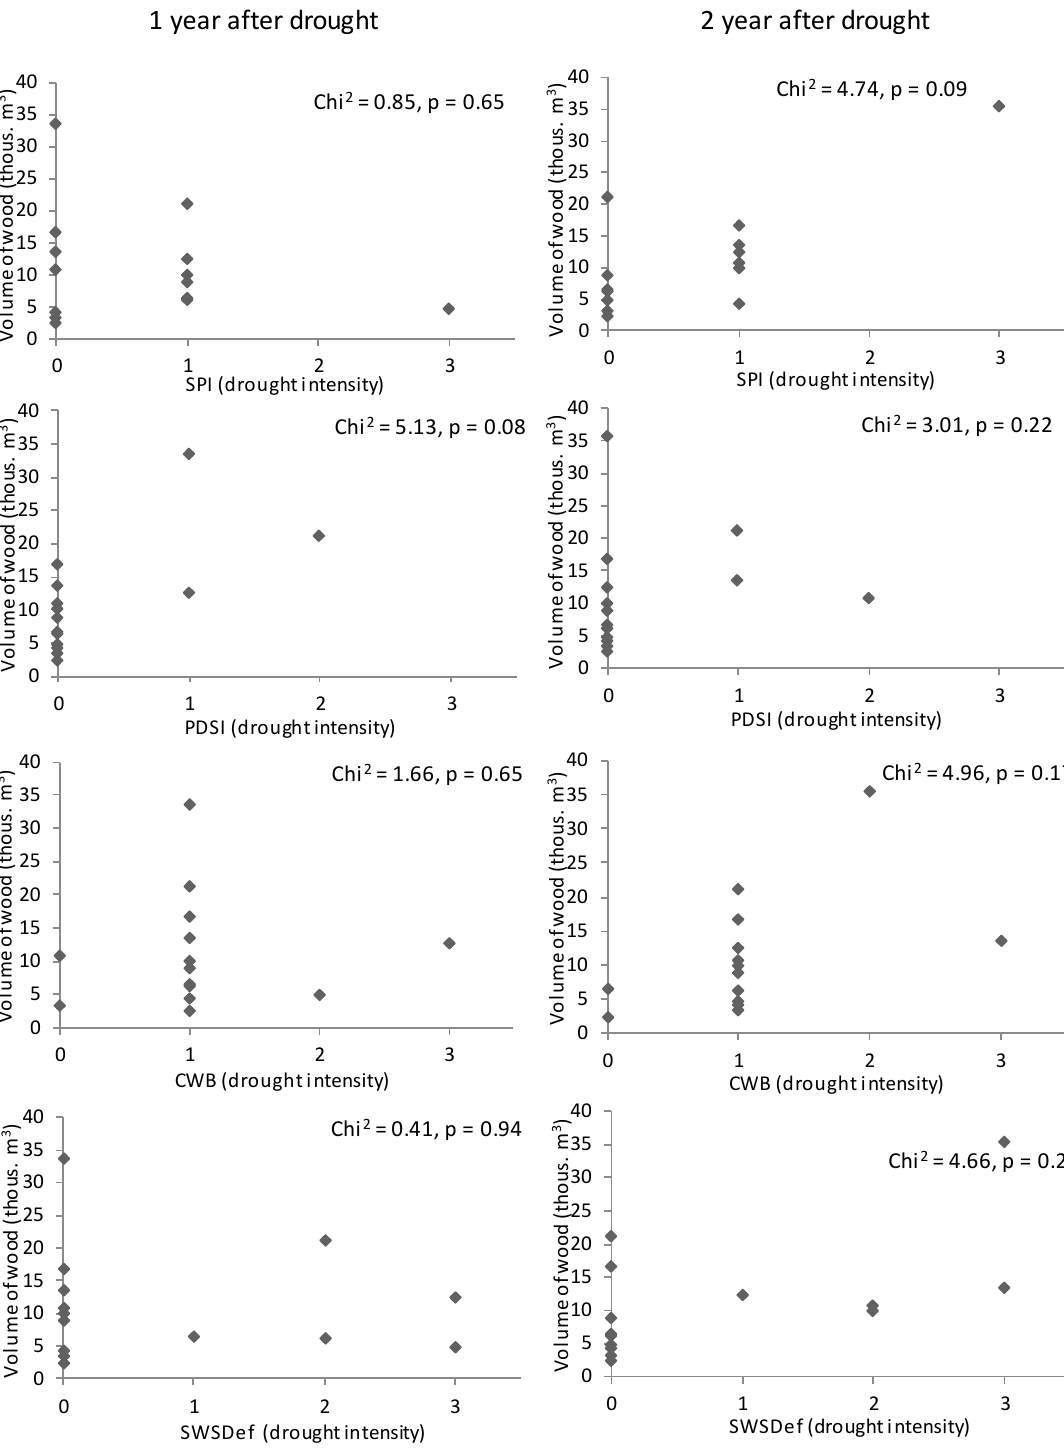
Figure 5. Relationship between drought indices (0—no drought, 1—moderate drought, 2—severe drought, 3—extreme drought) and volume of spruce wood cut in the 1st and 2nd year after drought.